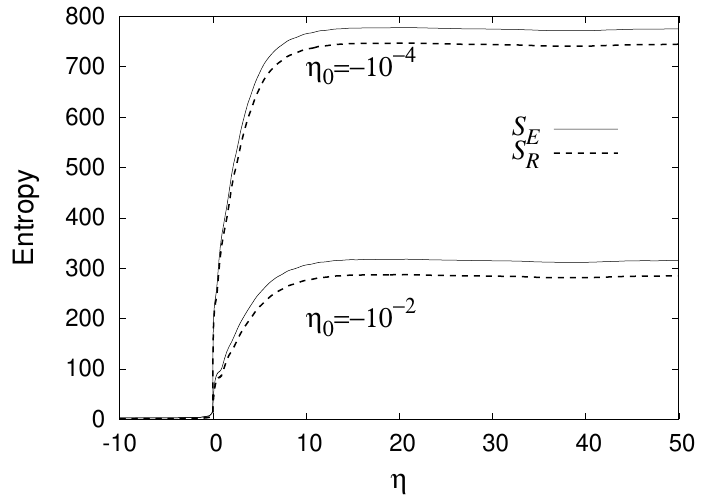
Figure 1 . Time dependence of the EE (solid lines) and the second R(cid:19)enyi entropy (dashed lines) for a 10 (cid:2) 10 square in the middle of a 31 (cid:2) 33 system. Larger entropies correspond to (cid:17) 0 = (cid:0) 10 (cid:0) 4 , and smaller to (cid:17) 0 = (cid:0) 10 (cid:0) 2 .